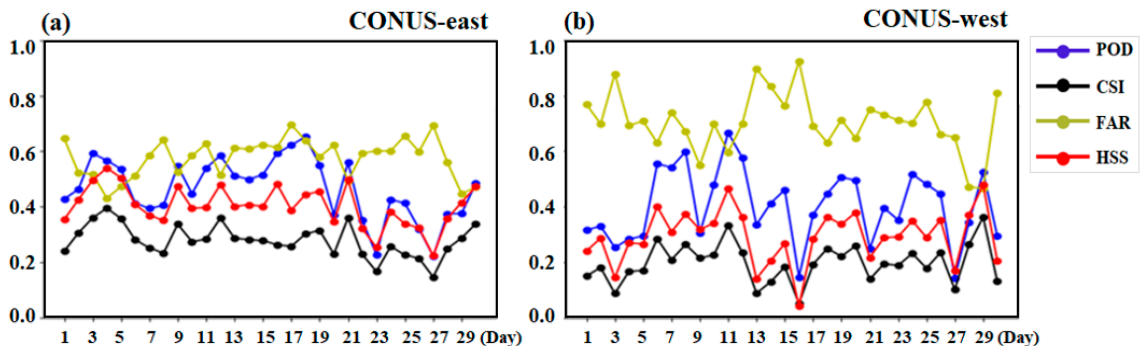
Figure 8. Month-by-month changes of the hourly evaluation results for GOES-16 QPE over CONUS-east in 2018 (top panels) and 2019 (bottom panels): ( a , c ) detection skill metrics; and ( b , d ) evaluation metrics for estimating rainfall intensity.